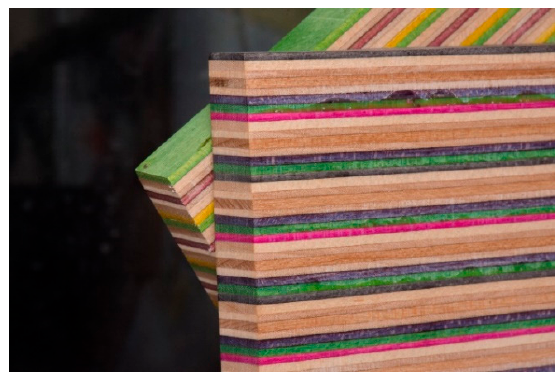
Figure 5. Composite Panels made by cutting skateboard decks into strips and gluing together.